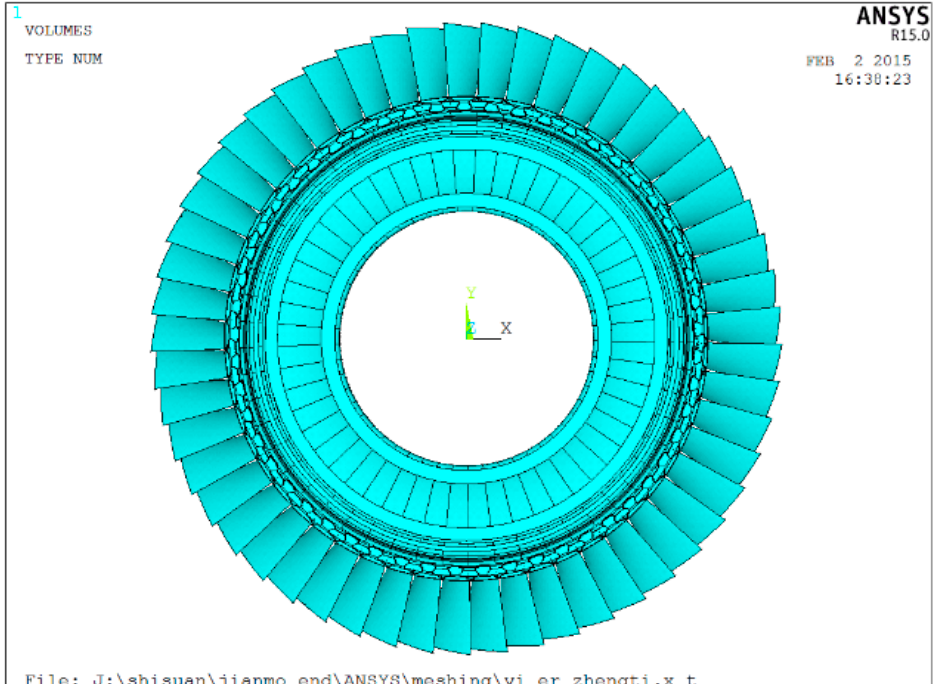
Figure 11. 3D solid model of the second-stage leaf disk.